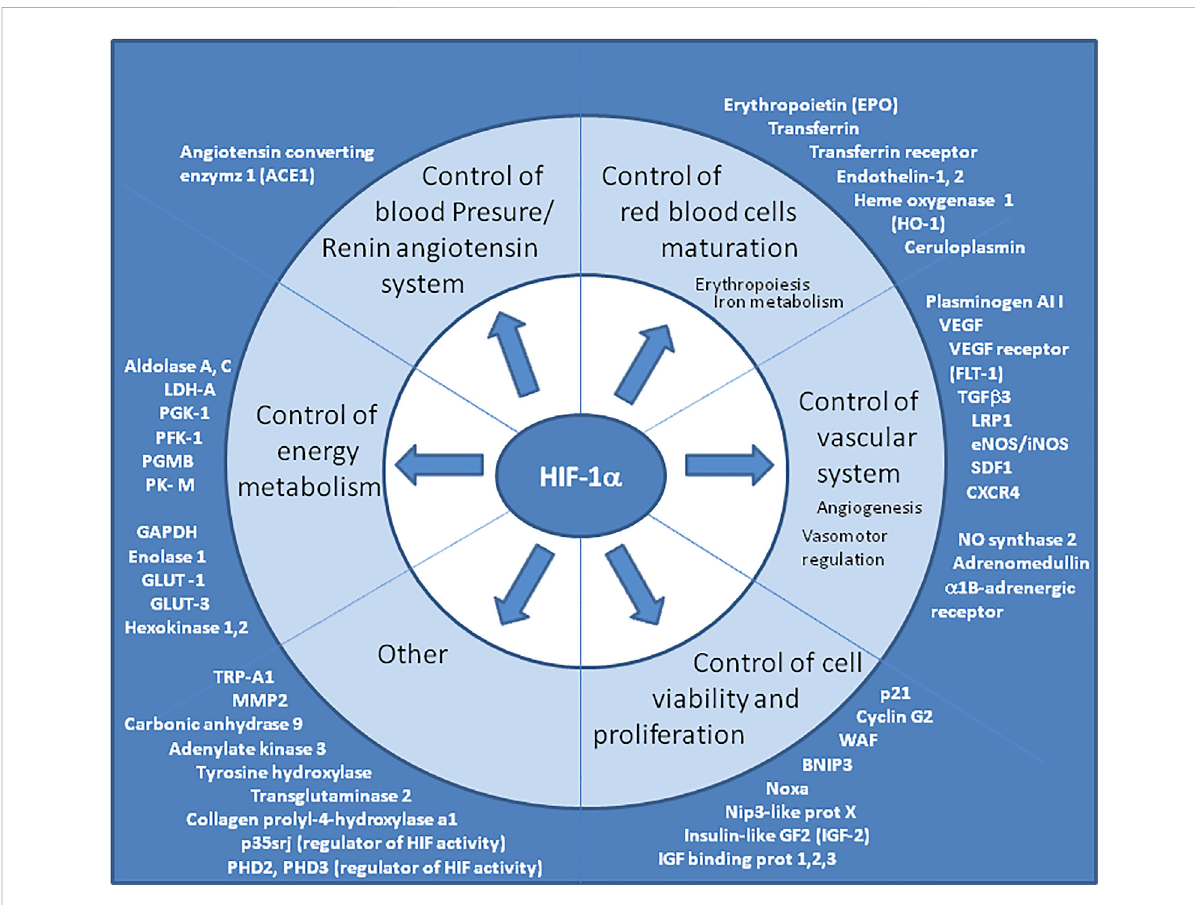
GenesupregulatedbyHIF “ masterregulator ” .TheconsensusDNAsequenceforHIF-1 α /HIF-1 β bindingiscommonformanygenesupregulated during hypoxia. Representative list of genes upregulated by HIF, however this list is not exhaustive and grows continuously. It is worth noting that severalgenesinvolvedintherenin-angiotensinsystem,inthedevelopmentandfunctioningofthevascularsystem(whichmodulatevasculartoneor promote angiogenesis) and in erythropoiesis, belong to this list. HIF-1 α is also known to upregulate TRP-A1 and p35srj. The p35srj protein is an alternatively spliced isoform of MRG1 which inhibits HIF-1 transactivation by blocking the HIF-1 α /p300